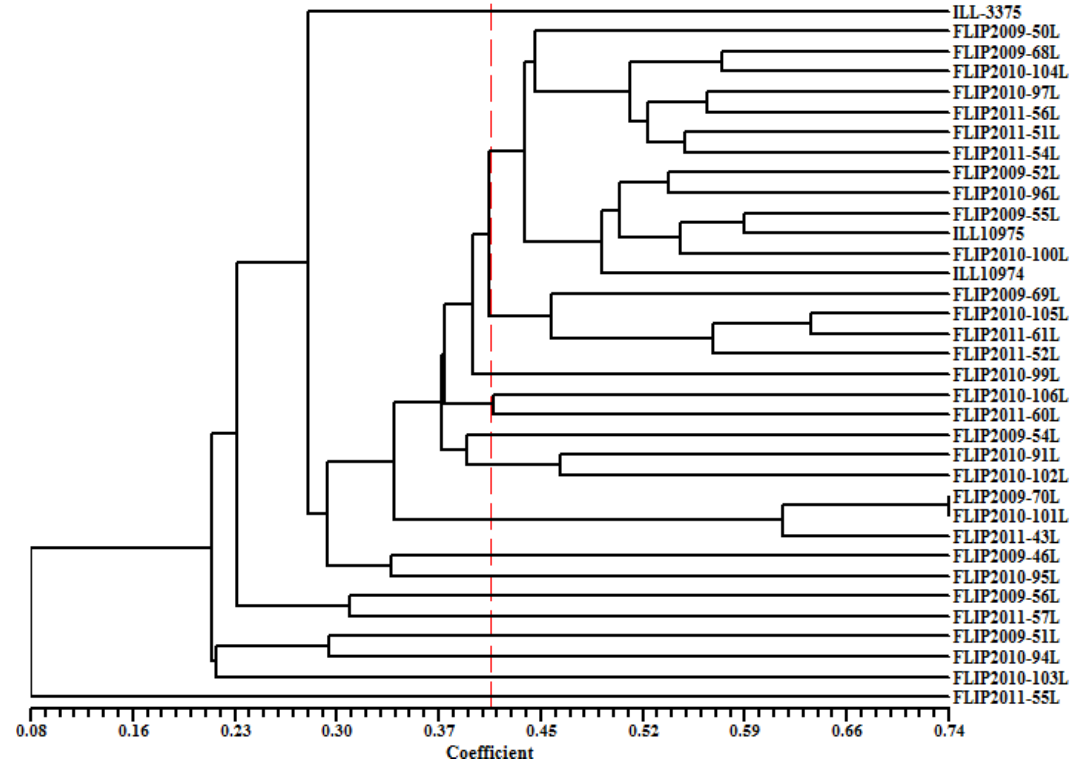
Figure 2. Dendrogram of 35 lentil genotypes generated from Sequence-related amplified polymorphism SRAP markers by Jaccard’s coefficient and UPGMA clustering method. Similarity values are shown at bottom of